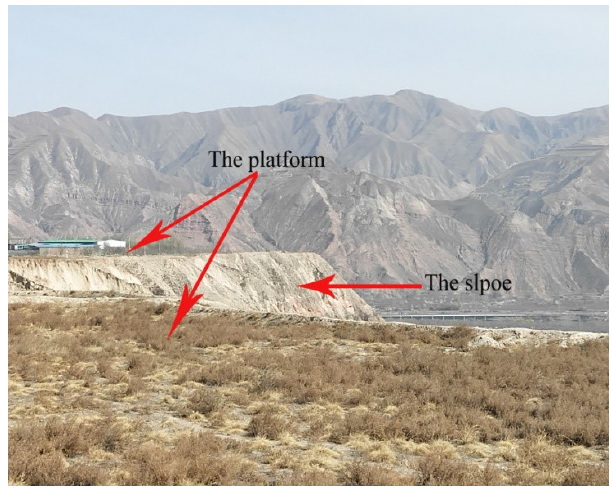
Figure 1. The topographic features of the studied area.